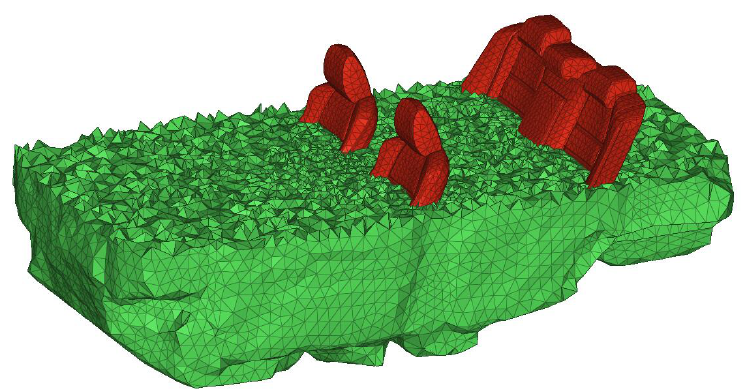
Figure 2. Sectional view of acoustic cavity